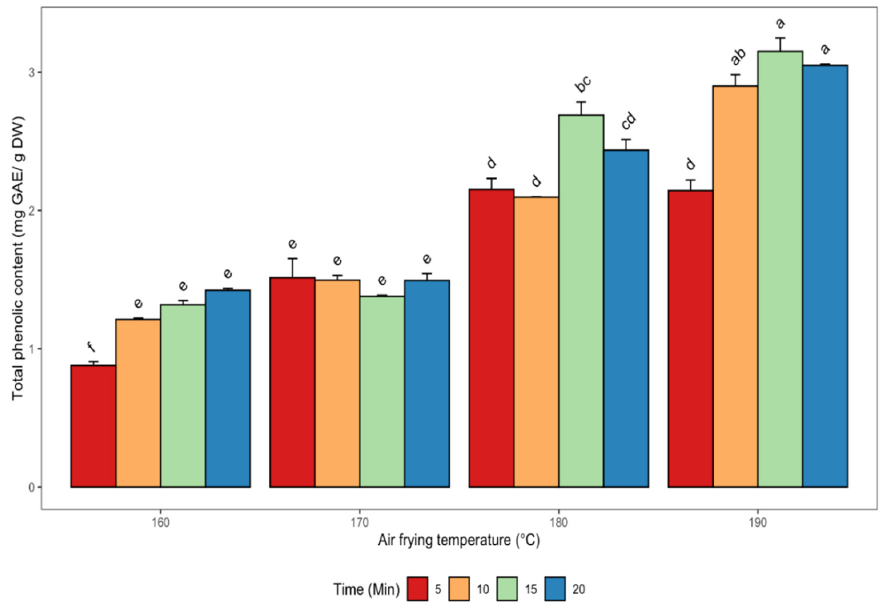
Figure 2. Changes in the total phenolic content of de-oiled canola meal extracts as affected by different air frying conditions. Error bars indicate the SD of the measurements for each sample ( n = 3). Bars with different letters (a–f) have significantly ( p < 0.05) different mean values.